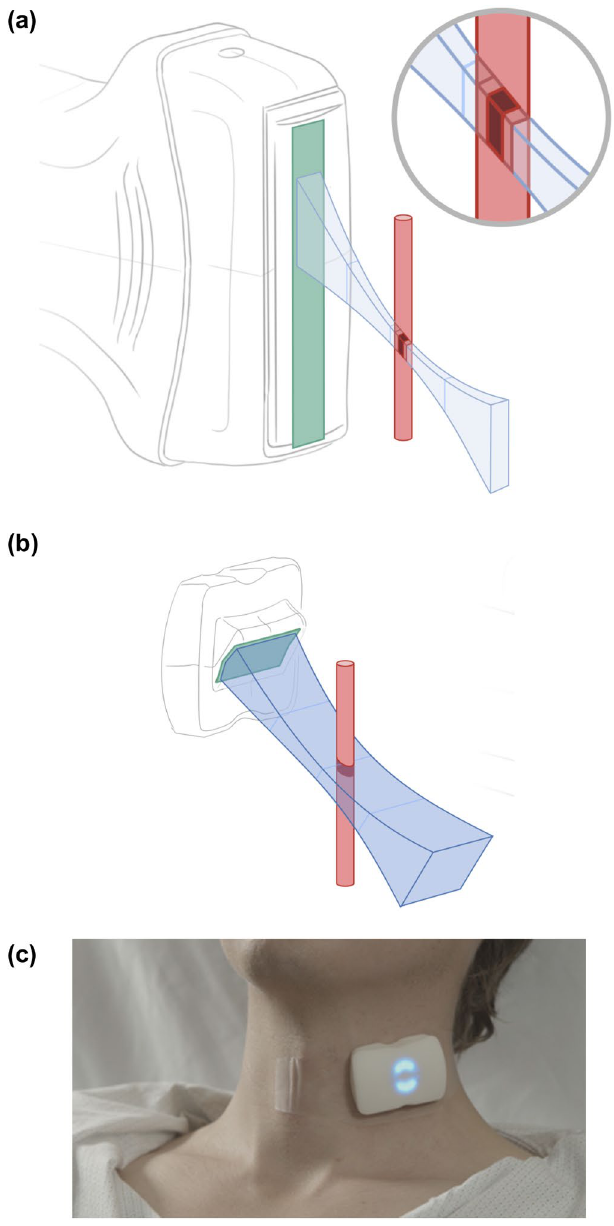
Figure 2. Using Doppler ultrasound to measure blood flow velocity in the carotid artery. ( a ) Using conventional PW Doppler, the handheld transducer is placed on the neck, and the Doppler sample window (dark red) is positioned in the centre of the artery. The Doppler angle cursor (black dashed line, see inset) is then aligned with the direction of blood flow to obtain an accurate velocity measurement. ( b ) With a broad-beam CW Doppler patch, the device is placed on the neck with the wide beam intersecting the cross-section of the carotid at approximately 60°. Doppler signals are simultaneously acquired from the entire beam area. ( c ) An adhesive strip secures the CW Doppler patch on the neck to maintain its position and angle over the course of repeated